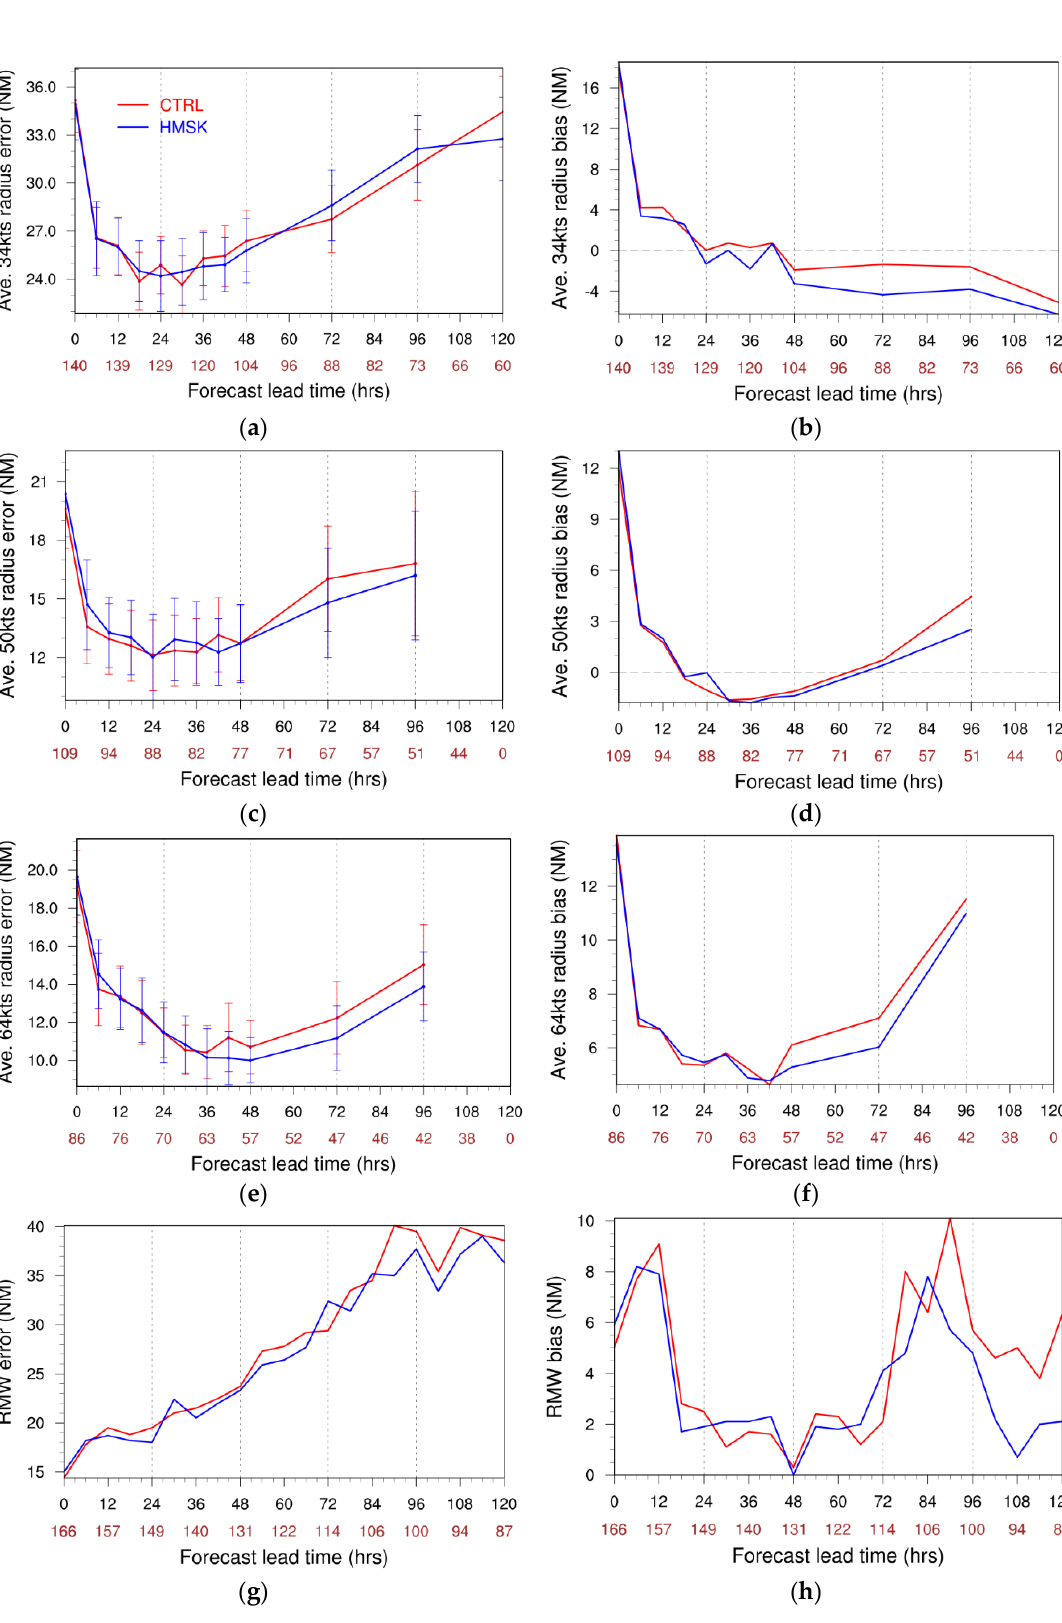
Figure 11. Storm size statistics between CTRL (red) and HMSK (blue) from four selected Atlantic hurricanes in 2017–2018. ( a ) 34 kt, ( c ), 50 kt ( e ), and 64 kt wind radii errors; ( b ) 34 kt, ( d ), 50 kt, and ( f ) 64 kt wind radii biases. ( g ) Radius of maximum wind (RMW) error and ( h ) bias. The error bar represents 95% confidence interval.